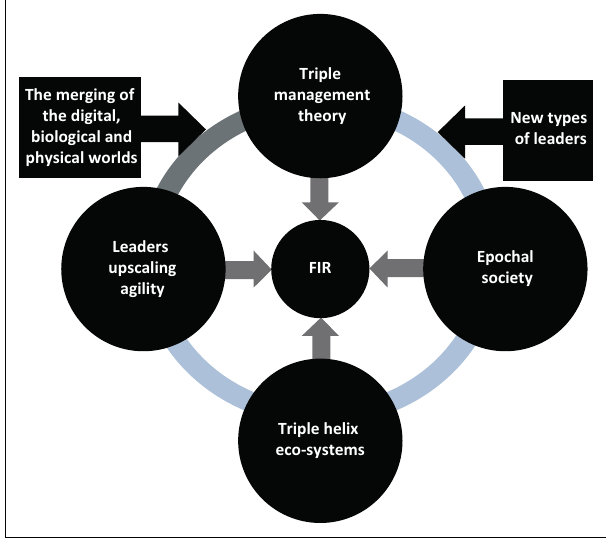
FIGURE 1: The quadruple helix model of